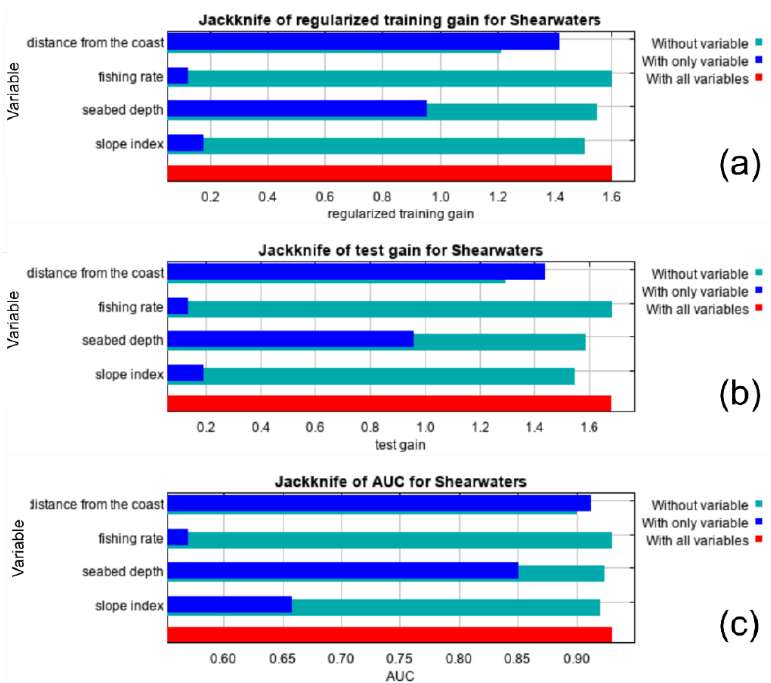
Figure 10. Results of the MaxEnt jackknife test of ( a ) regularized training gain, ( b ) test gain, and ( c ) AUC, for shearwaters. It shows the importance of each variable (distance from the coast, fishing rate, seabed depth, slope index) by excluding each variable (light blue), by considering only that variable (blue), and then by considering all the variables together (red).